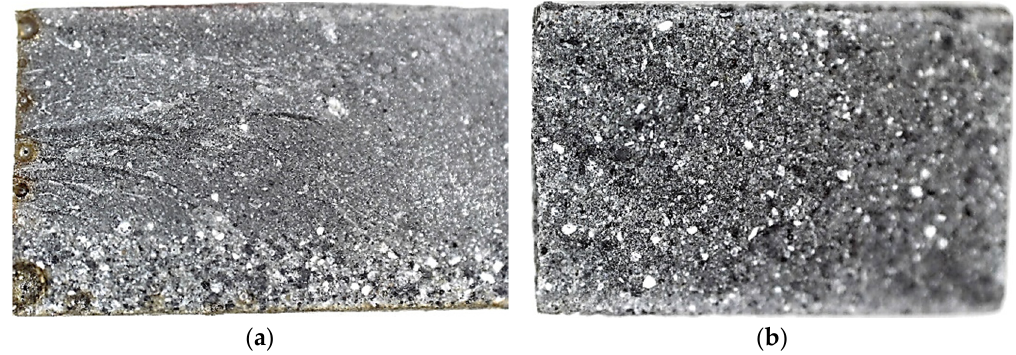
Figure 14. Cross ‐ sections of filled samples: ( a ) EP ‐ FA25; ( b ) EP ‐ FA50. The correlation of wear values at impingement angles of 45° and 90° with elasticity